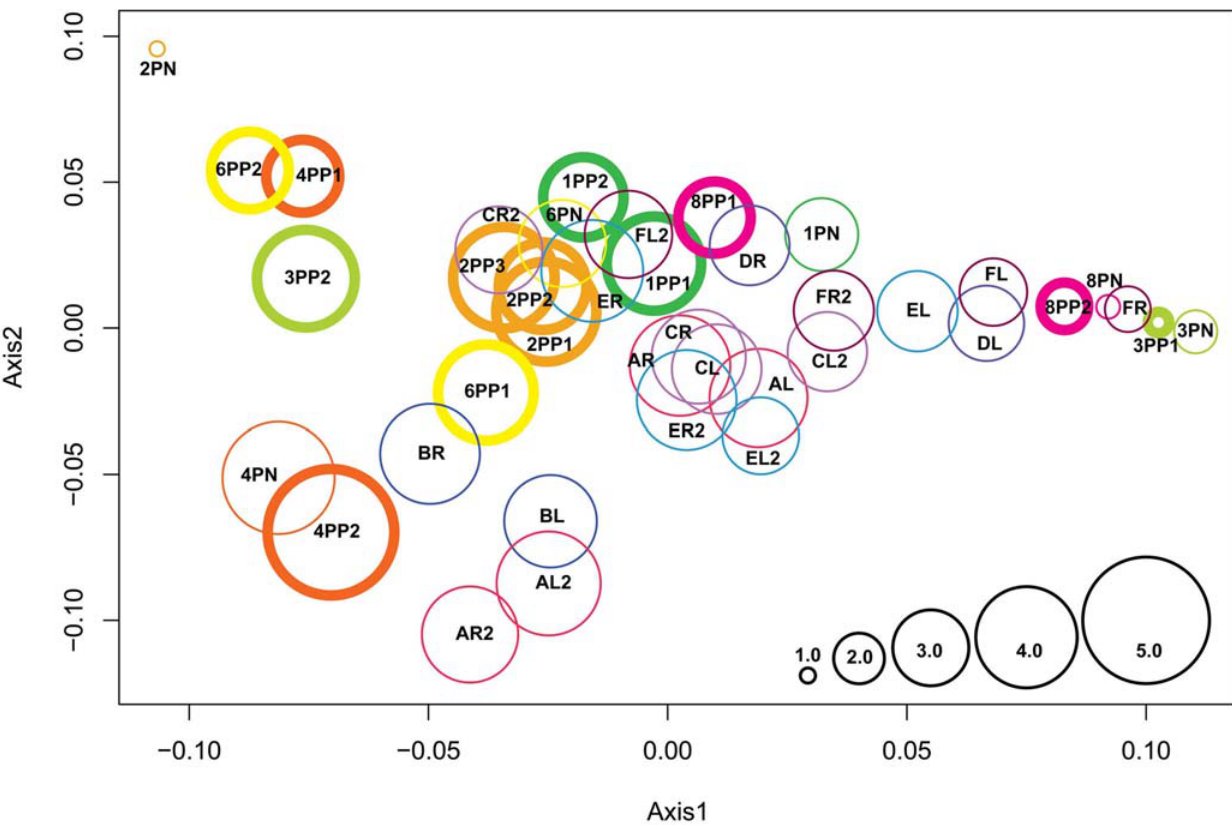
Figure 4. DPCoA of SLOTU relatedness in 39 human skin samples obtained from healthy subjects and psoriatic patients. The healthy subjects were designated A–F, and at each sampling both left (L) and right (R) forearm skin was examined. In four subjects, new specimens were obtained 8–10 months later (e.g. designated AL2). The psoriatic patients were designated 1, 2, 3, 4, 6, and 8, PN indicates that sample is from uninvolved skin and PP is from psoriatic lesions. In a representation of the first two orthogonal principal axes, based on a sample dissimilarity matrix, samples from the same subjects at the same time point are plotted by using the same color, and the normal skin and psoriatic lesion samples are indicated by thin and thick circle walls, respectively. The size of each circle is proportional to the sample’s Rao diversity index. The scale (bottom right) indicates the relative diversity of the populations within the circles, with the test sample of smallest diversity (2PN) indexed as 1.0.